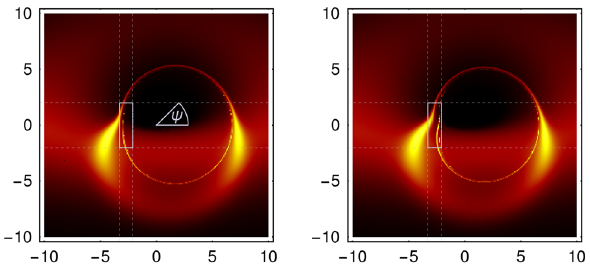
Fig. 2 Relative intensity in the ( x , y ) image plane, normalized to the brightest image point (of both images), cf. color legend in Fig. 1. Left: Kerr black hole; Right: regular black hole with M exp with (cid:11) NP = 0 . 2556 m ≈ (cid:11) NP,crit . We choose a = 0 . 9 m , inclination θ obs = 8 π/ 20, and disk parameter h = 10 m in both panels. The gray boxes indicate the prograde region in which the deviations from Kerr spacetime are the largest, cf. Fig. 3 for detail